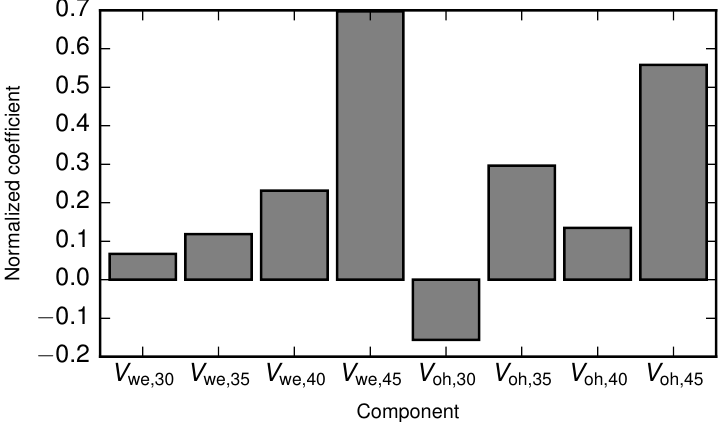
Figure 11. Normalized coefficients for the linear discriminant analysis model.